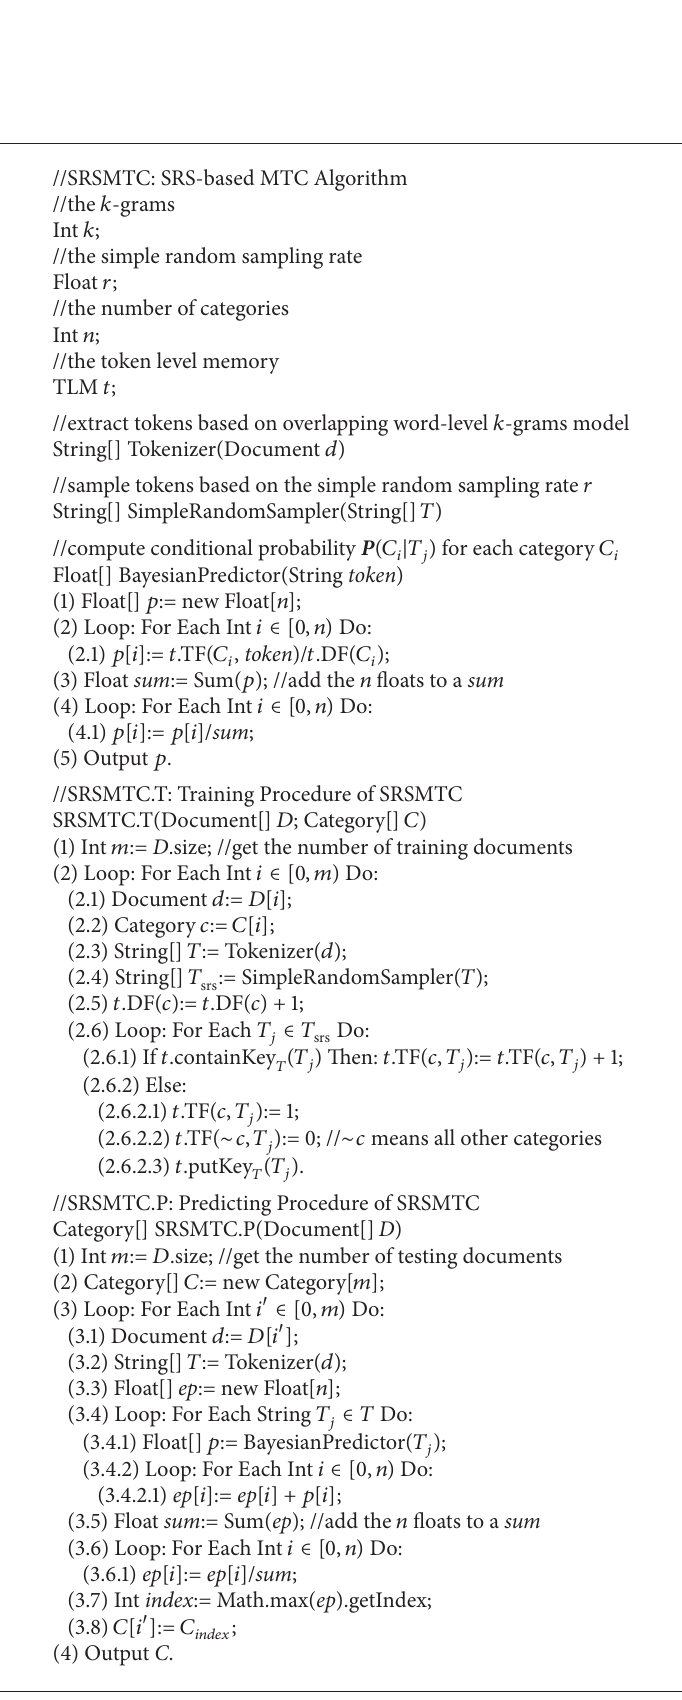
Algorithm 1: Pseudo-Code of SRSMTC